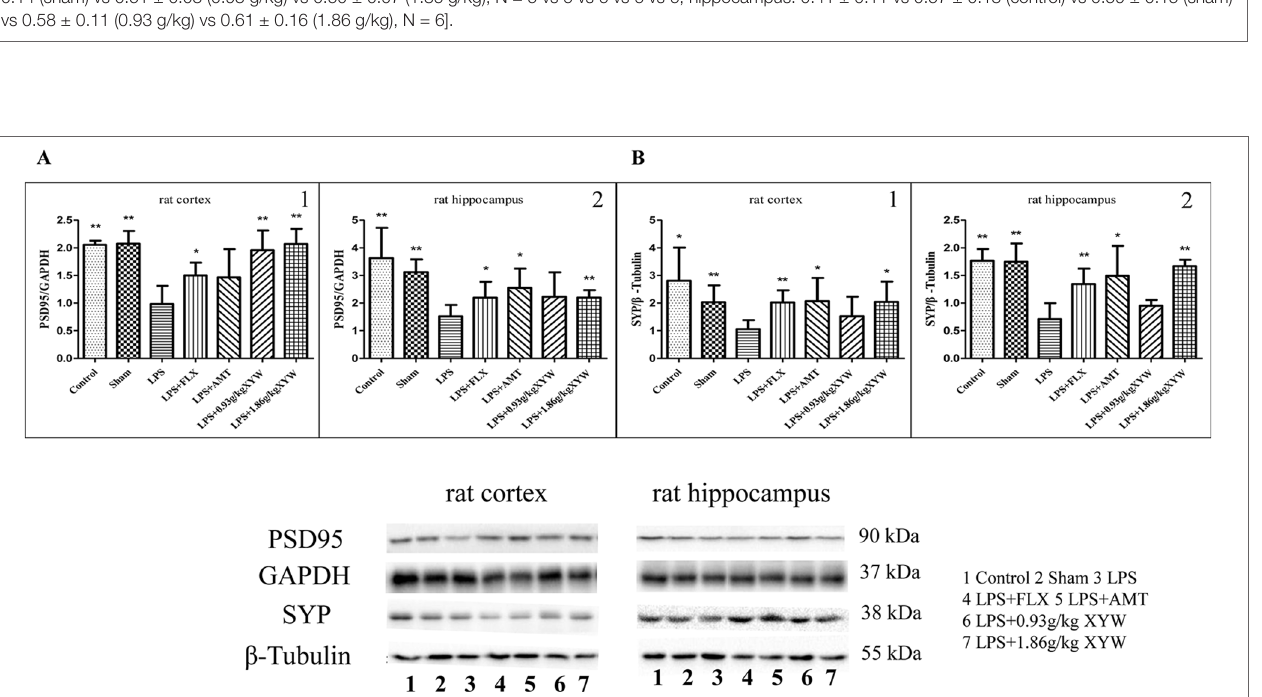
FIgURe 6 | LPS administration acutely reduced postsynaptic density protein 95 (PSD)-95 and synaptophysin (SYP) in different brain regions. (a, B) Rats, PSD95 (cortex:0.98 ± 0.33 vs 2.05 ± 0.08 (control) vs 2.08 ± 0.23 (sham), N = 6, hippocampus: 1.52 ± 0.41 vs 3.63 ± 1.09 (control) vs 3.12 ± 0.46 (sham), N = 6) and SYP (cortex:1.05 ± 0.33 vs 2.81 ± 1.20 (control) vs 2.03 ± 0.61 (sham), N = 6, hippocampus: 0.71 ± 0.29 vs 1.77 ± 0.21 (control) vs 1.75 ± 0.33 (sham), N = 6) were lower in the hippocampus and cortex in LPS treated group than the control (P 0.05 or P 0.01). with 2 weeks of prior XYW administration (LPS + XYW [1.86 g·kg -1 ]), exhibited a significantly higher level of PSD-95 and SYP in the cortex and hippocampus. 0.93 g·kg -1 Xiaoyao Pills also increased PSD-95 protein in the cortex (PSD- 95: cortex:0.98 ± 0.33 vs 1.96 ± 0.35 (0.93 g/kg) vs 2.07 ± 0.27 (1.86 g/kg), N = 6, hippocampus: 1.52 ± 0.41 vs 2.23 ± 0.89 (0.93 g/kg) vs 2.20 ± 0.27 (1.86 g/ kg), N = 6) (SYP: cortex: 1.05 ± 0.33 vs 1.52 ± 0.71 (0.93 g/kg) vs 2.04 ± 0.73 (1.86 g/kg), N = 6, hippocampus: 0.71 ± 0.29 vs 0.95 ± 0.11 (0.93 g/kg) vs 1.67 ± 0.12 (1.86 g/kg), N = 6) (P 0.05 or P 0.01) (A1: Mann-Whitney test, A2, B1-2: t-test). Compared with the LPS group, * P < 0.05,** P <